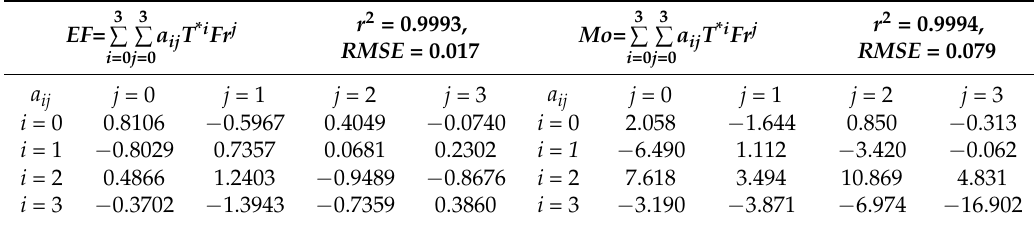
Table 1. Generalized Triangle Method coefficients used to estimate EF and Mo . From Carlson (2007). 3 EF =